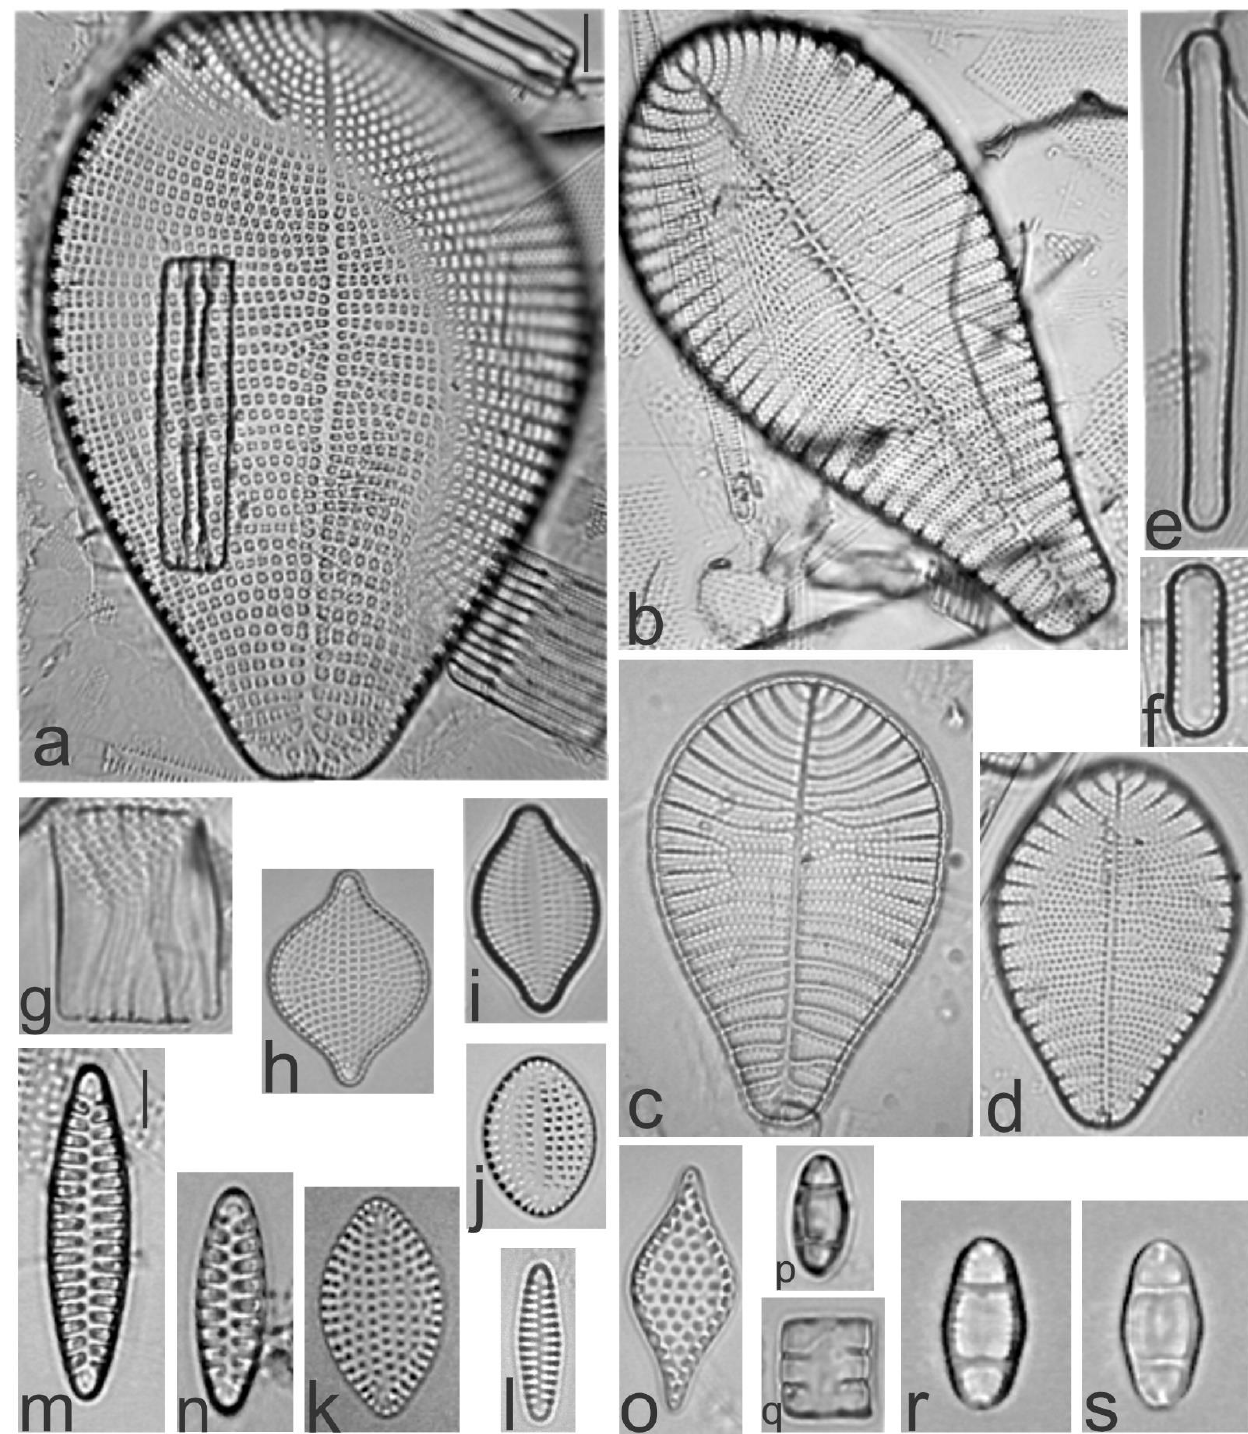
Figure 8. ( a ) Podocystis spathulata ; ( b – d ) P. americana ; ( e ) Thalassionema nitzschioides ; ( f ) T. nitzschioides var. parvus ; ( g ) Hyalosira tropicalis ; ( h , i ) Rhaphoneis amphiceros ; ( j , k ) Delphineis minutissima ; ( l ) Neodelphineis silenda ; ( m , n ) cf. Staurosirella martyi ; ( o ) Cymatosira lorenziana ; ( p – s ) Anaulus cf. balticus . Scale bars = 5 μm.